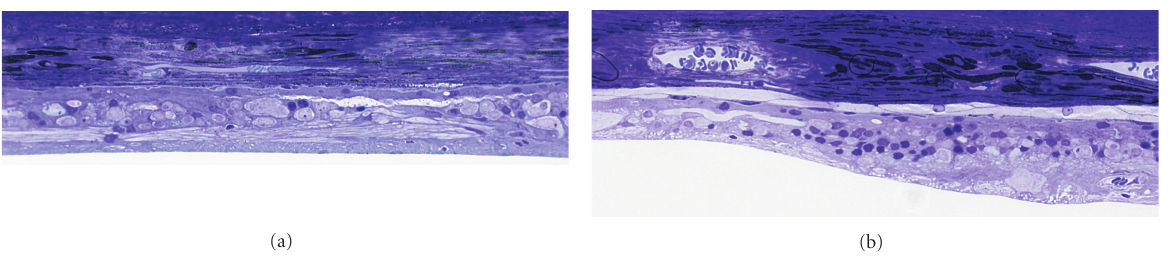
Figure 4: (a) Light microscopy (LM) of the inferior nontapetal retina of the 9-year-old ESS dog. Severe thinning of the entire retina is seen with complete degeneration of photoreceptor cells and inner retinal degeneration, disorganization, and gliosis. (b) LM of superior tapetal retina. A variation in retinal thickness is observed and some areas with a single row of photoreceptor nuclei that are still present. Toluidine blue staining; ×